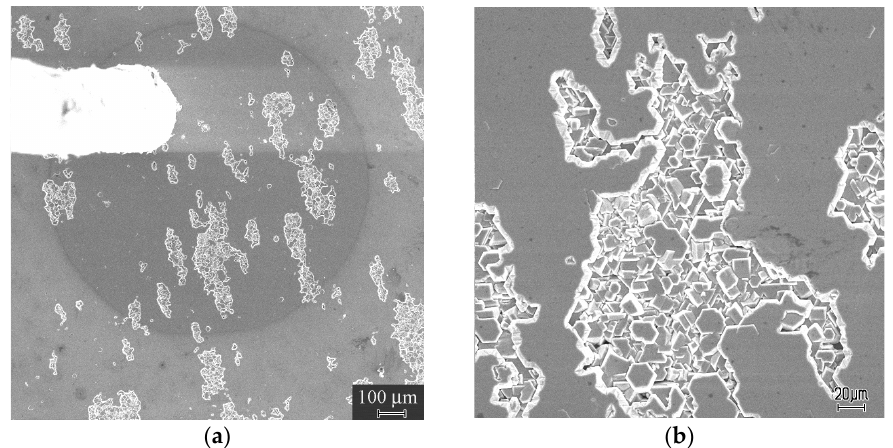
Figure 2. Secondary electron image of thin κ -Ga 2 O 3 film with the Schottky diode for electrical measurements ( a ) and a fragment of the image with the higher magnification ( b ).